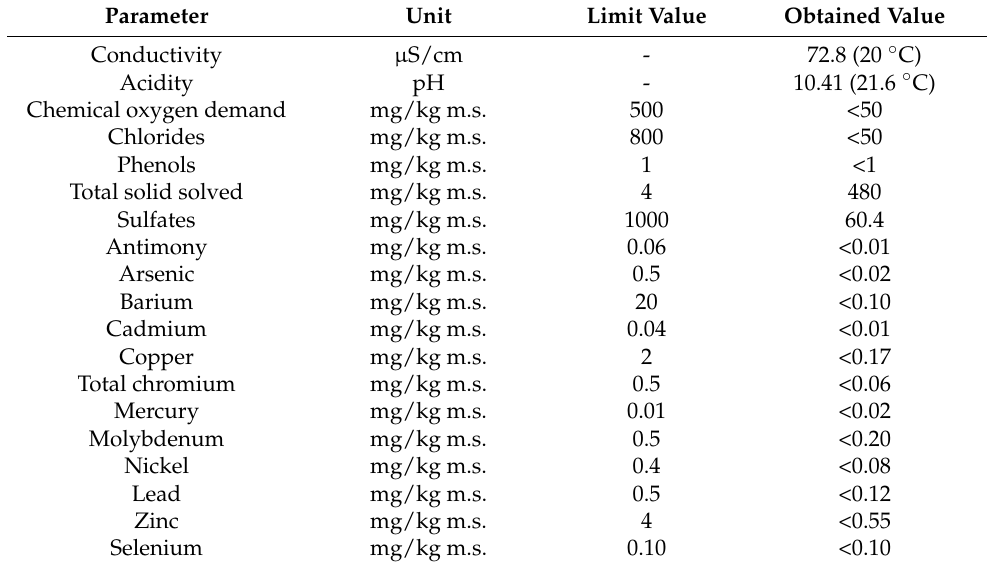
Table 1. Results of the cupola slag leaching test.